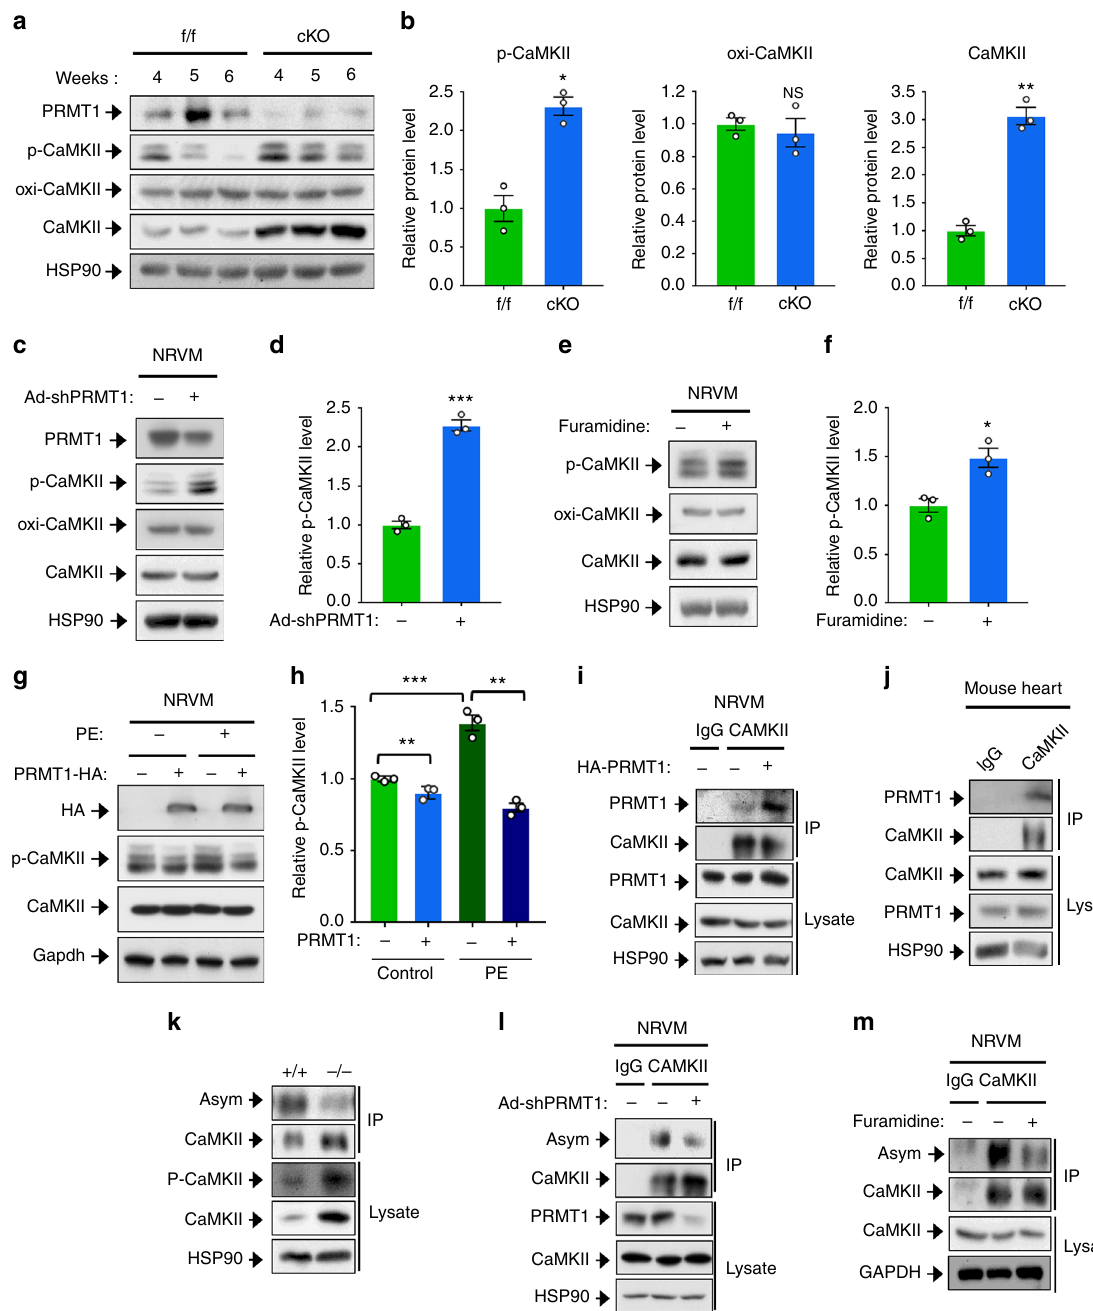
Fig. 4 PRMT1 inhibits CaMKII through interaction and methylation. a Immunoblotting for p-CaMKII (phosphorylated- Thr286/287 CaMKII), oxi-CaMKII (oxidized CaMKII), and total CaMKII in f/f and cKO mice between 4 to 6-weeks of age. b Relative p-CaMKII protein levels in 6-weeks-old hearts. n = 5. Data represent means ± SD. * P < 0.05, ** P < 0.01, Student ’ s t -test. c , d Protein analysis of PRMT1-depleted NRVM and quanti fi cation of relative signal intensity. n = 3. Data represent means ± SD. *** P < 0.001, Student ’ s t -test. e , f Protein analysis of NRVM treated with a PRMT1-speci fi c inhibitor furamidine for 4 h and quanti fi cation of relative signal intensity. n = 3. Data represent means± SD. * P < 0.05, Student ’ s t -test. g Analysis for CaMKII levels in control and PRMT1 overexpressing NRVM cells treated with PE for 1 day. h Quanti fi cation of relative protein levels similar experiments shown in g . n = 3. Data represent means± SD. ** P < 0.01, *** P < 0.001, Student ’ s t -test. i , j Coimmunoprecipitation of PRMT1 with CaMKII in NRVMs and mouse heart. Immunoprecipitation with rabbit IgG serves as control. k , l , m Analysis of asymmetric dimethylation of CaMKII in wild-type and cKO heart lysates, PRMT1- depleted and furamidine-treated NRVM. Lysates were immunoprecipitated and immunoblotted with anti-Asym reduced by KN93 treatment (Fig. 5b, c). In addition, CaMKII for 12 h, followed by immunoblotting and qRT-PCR analysis inhibition restored the increase in ANP and β -MHC gene (Supplementary Fig. 10). Similarly to the results with KN93 expression caused by PRMT1 knockdown (Fig. 5d). To validate treatment, AC3-I treatment reduced ANP, BNP, β -MHC gene the KN93 effect, control or PRMT1-depleted NRVM cells were expression in PRMT1-depleted cells, while AC3-C had no sig- treated with a CaMKII inhibitor peptide, AC3-I or control AC3-C ni fi cant effect, compared to PRMT1-depleted cells. These data